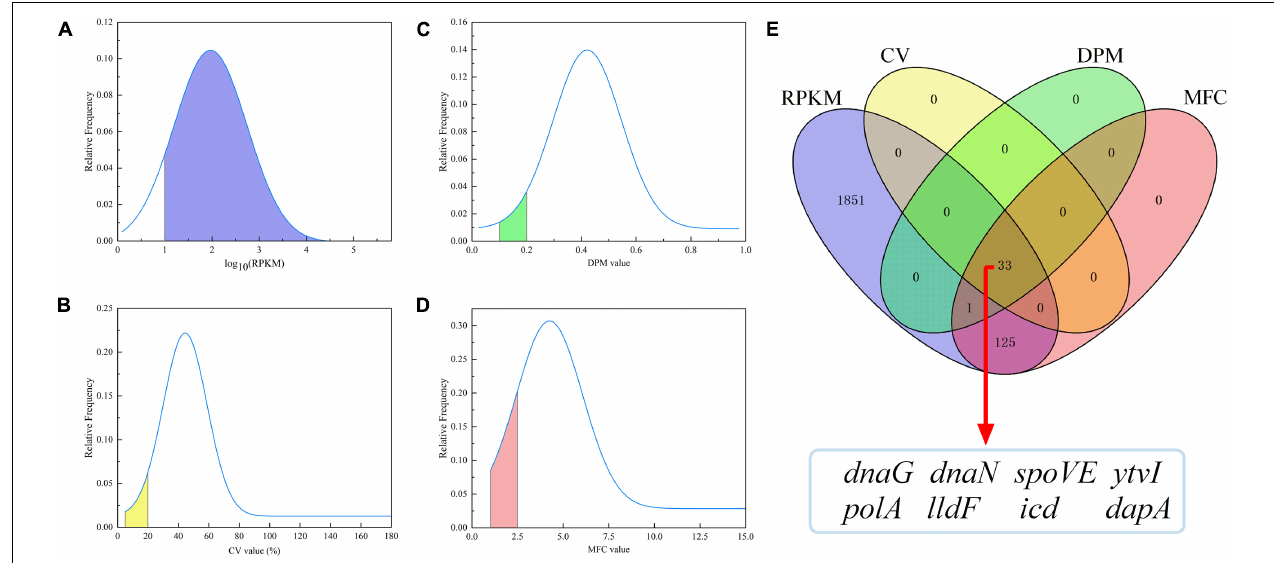
FIGURE 2 | Probability density curve of RPKM, CV, DPM, and MFC values of 2751 genes (A–D) , and the overlap genes obtained by the Venn diagram analysis (E) . RPKM, reads per kilobase of transcript per million mapped reads; CV, coefficient of variation; DPM, dispersion measure; MFC, maximum fold